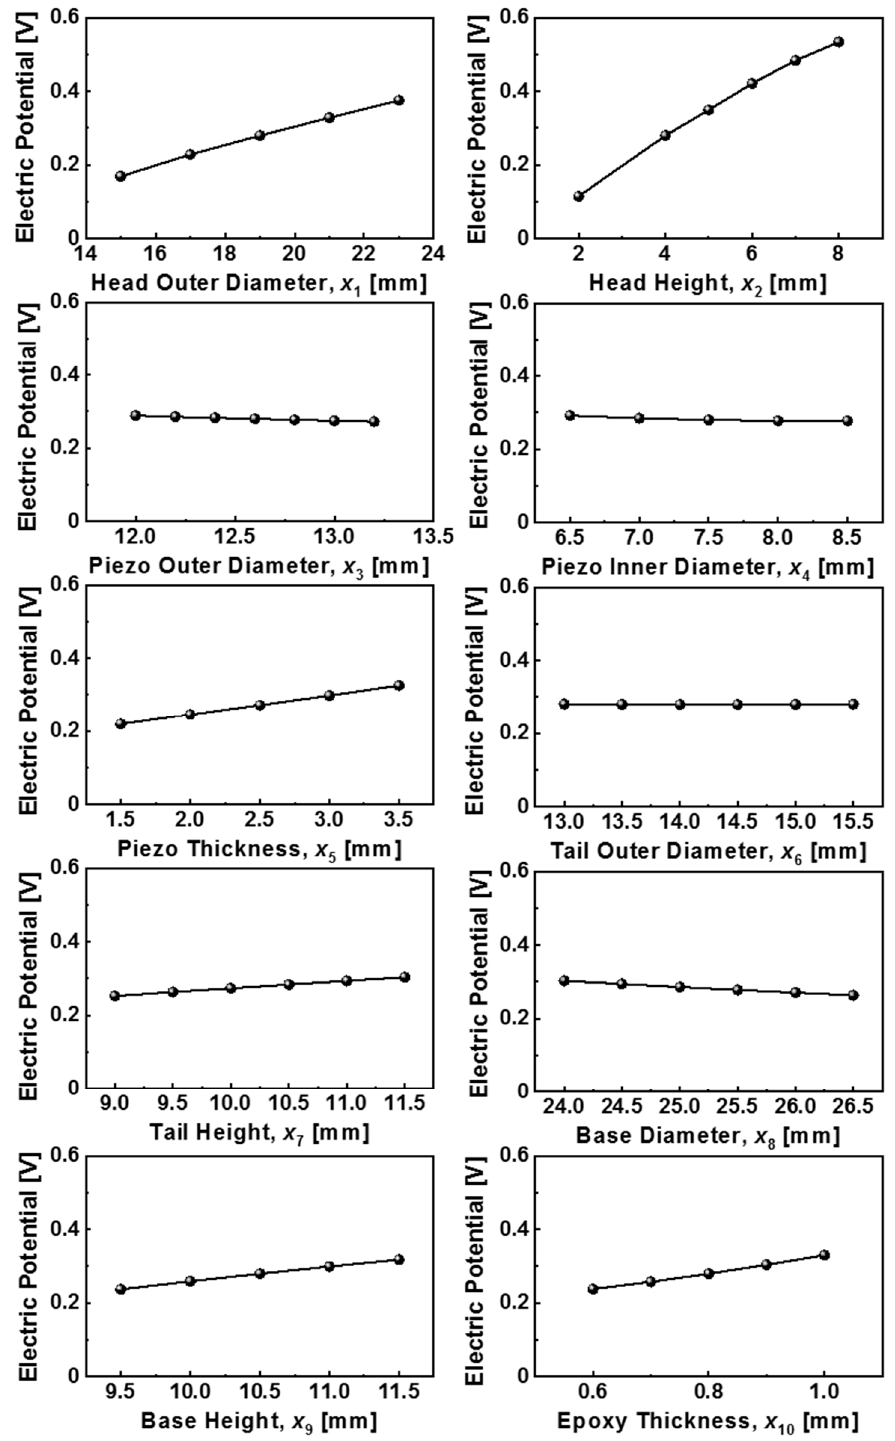
Figure 5. The changes in the electric potential according to the values of each component constituting the sensor module.